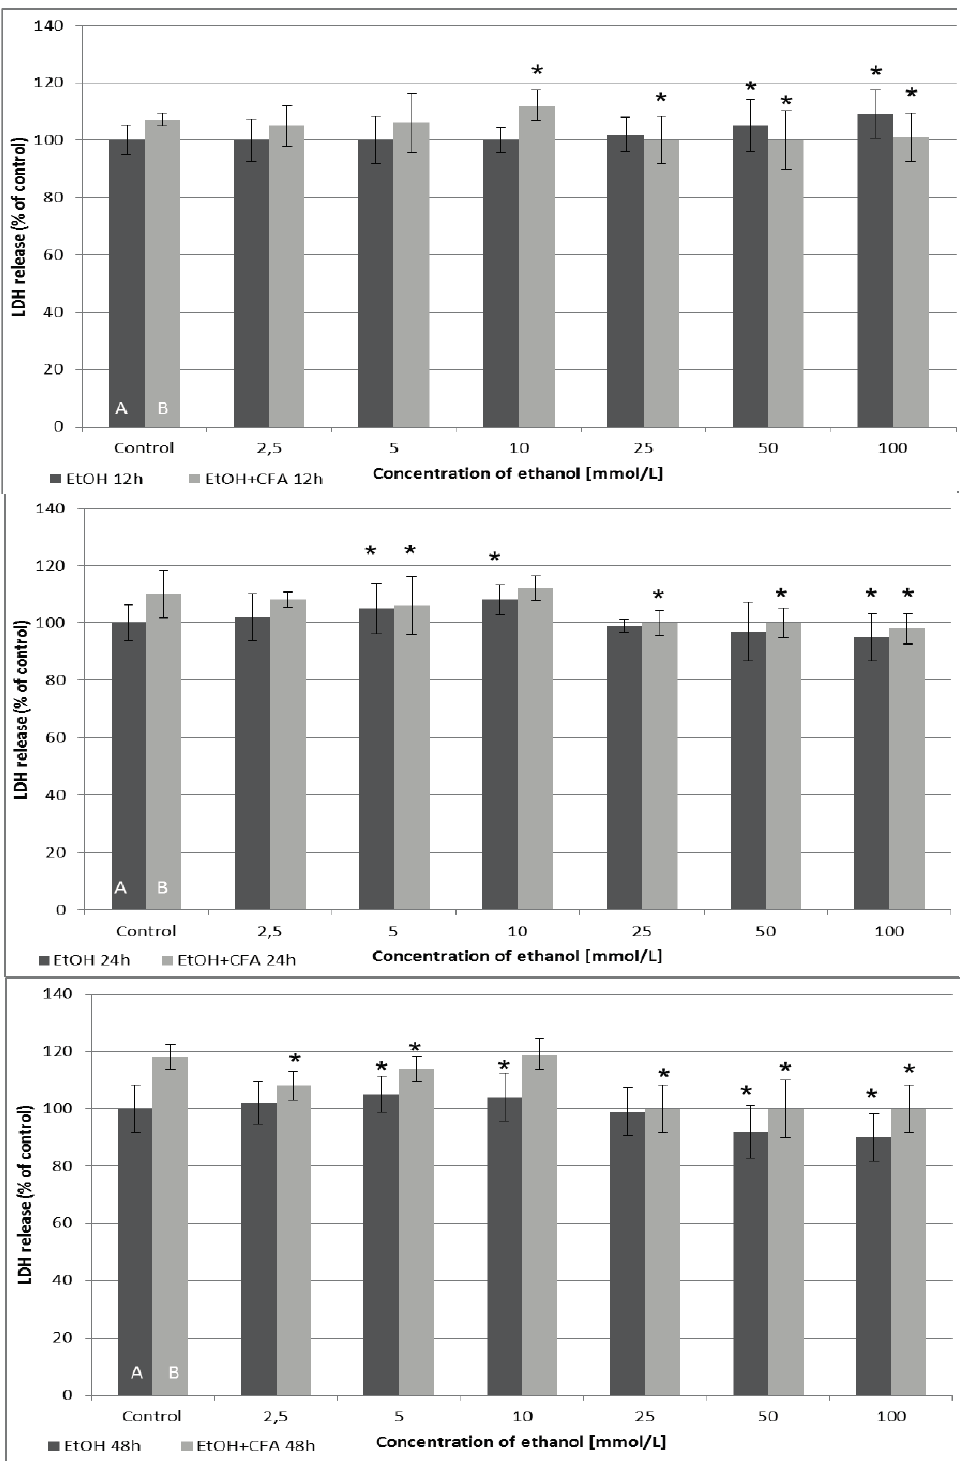
Figure 4. Cytotoxic effects measured by lactate dehydrogenase (LDH) enzymatic activity in human tongue carcinoma cells and after treatment with CFA and EtOH. LDH levels are measured following treatment with 50 µmol/L of CFA for 12, 24 and 48 h (2 and 6 h exposure time is omitted). Ethanol concentration—dependent quantification of LDH activity released from damaged SCC-25 cells. Control A includes native cells and medium alone whereas control B includes native cells, medium and CFA (50 μ mol/L) without EtOH. ( * ) indicates statistically significant differences compared to the